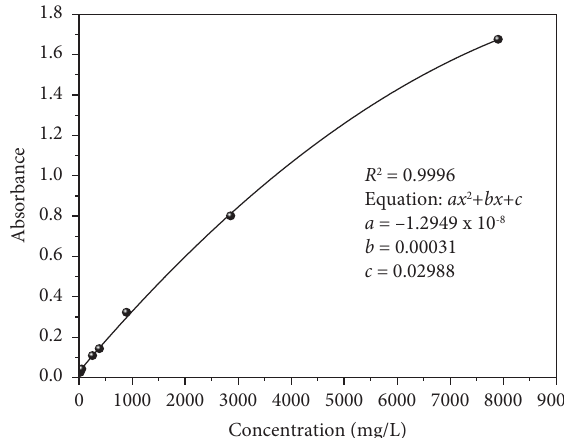
Figure 4: Calibration curve of the sucrose standard dissolved in water. Figure 2: Graph of peak absorbance versus slit width of the sucrose